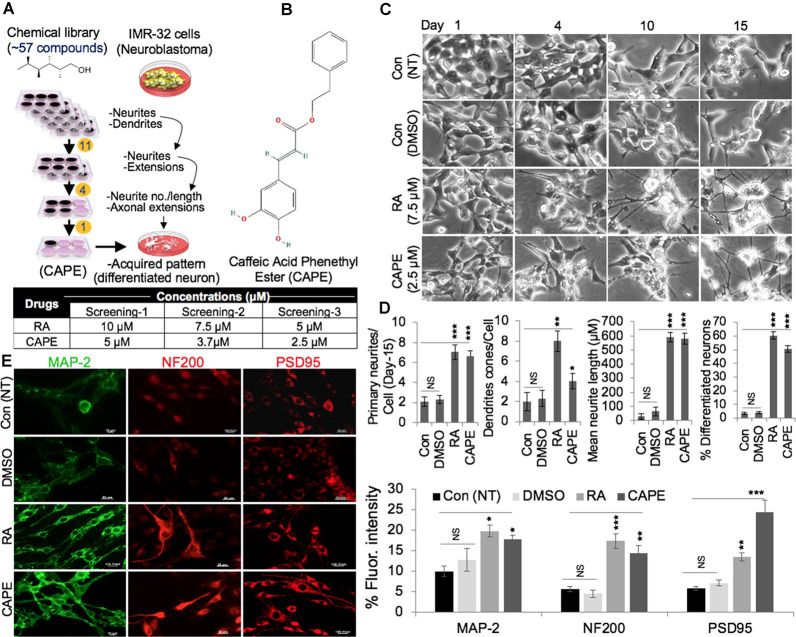
Identification of caffeic acid phenethyl ester (CAPE) as a neurodifferentiation-inducing natural compound. (A) Schematic diagram showing a multistep selection protocol for compounds that induced neurodifferentiation phenotype (neurites and dendrites) in IMR32 (human neuroblastoma cells). The concentration of retinoic acid (RA) and CAPE used in three screening steps are summarized in Table. (B) The structure of CAPE is shown. (C) Phase-contrast images (from days 1, 4, 10, and 15) showing differentiating phenotypes nontreated (NT, blank) and dimethylsulfoxide (DMSO)-, RA-, and CAPE-treated IMR32 cells. (D) Quantitation of the distinct differentiation (number of neurites, dendrites, and neurons) features in the nontreated (NT, blank) and DMSO-, RA-, and CAPE-treated IMR32 cells. (E) Immunostaining of MAP-2, NF200, and PSD95 in the nontreated (NT, blank) and DMSO-, RA-, and CAPE-treated IMR32 cells. Cells were treated for a week. Quantitation of immunofluorescence intensities is shown next to the images (scale bar, 20 μm). The data were expressed as mean ± SD. The p-values were represented as *p < 0.05, **p < 0.01, and ***p < 0.001. NS, non-significant.